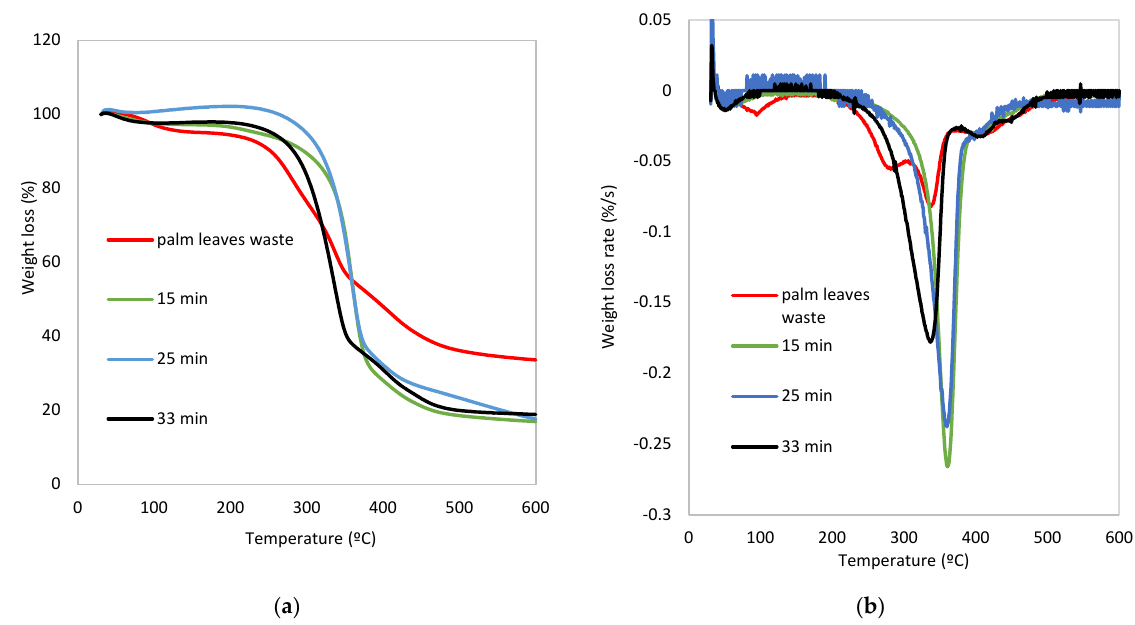
Figure 4. ( a ) TGA and ( b ) DTA curves corresponding to pruning waste and the resulting fibers. Table 2 compiles the results obtained from the differential thermogravimetric analysis (TGA) in which the initial composition of pruning waste corresponding to moisture (peak 1, 94.7 °C), hemicellulose content (peak 2, 281 °C), cellulose (peak 3, 335 °C) and lignin content (peak 4, 410 °C) are included. The results show that the peak corresponding to cellulose in pruning waste and the process at 33 min produce a maximum of decompo- sition at the same temperature (335 and 338 °C, respectively). However, at 15 and 25 min,